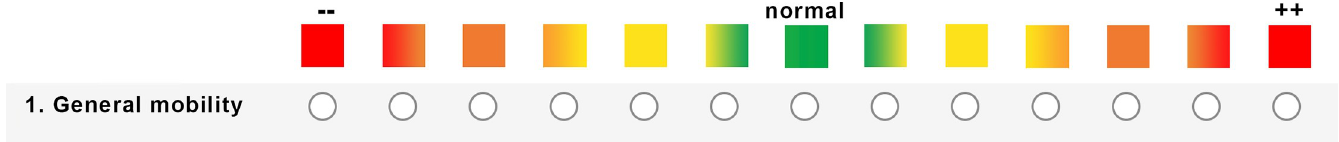
PLOS ONE | https://doi.org/10.1371/journal.pone.0252536 June 4,